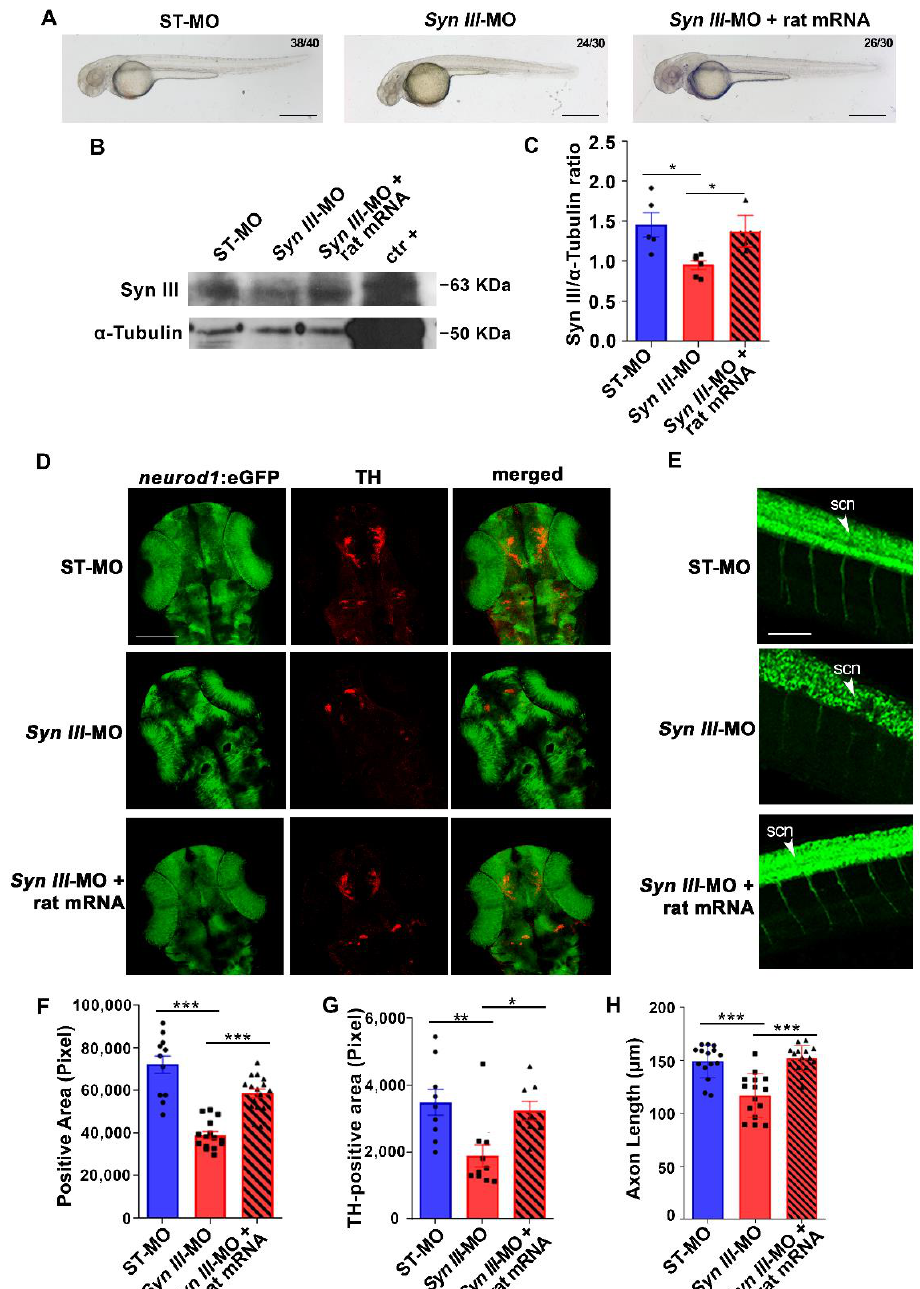
Figure 4. The neurodevelopmental deficits rescued by rat Syn III mRNA expression of Syn III -MO- injected Tg( neurod1 :eGFP) embryos involve TH-positive dopaminergic neurons. ( A ) Representative images showing embryos injected with non-silencing ST-MO, Syn III -MO or Syn III -MO and rat mRNA ( Syn III- MO + rat mRNA). Scale bars, 100 μm. ( B ) Representative WB from protein extracts of ST-MO-, Syn III -MO- or Syn III -MO + rat mRNA-injected Tg( neurod1 :eGFP) embryos. The positive control is a protein extract obtained from the striatum of twelve-month-old C57BL/6J wt mice. Al- pha-Tubulin bands are representative of the equal loading of samples. ( C ) Graphs show the ratio between the optical de nsity (o.d.) of Syn III and α -Tubulin of ST-MO, Syn III -MO, and Syn III -MO + rat mRNA-injected Tg( neurod1 :eGFP) embryos. Syn III was significantly reduced in the embryos exposed to syn3 KD when compared to either control or Syn III -MO + rat mRNA (* p < 0.05, One- way Anova + Newman-Keuls, n = 5 zebrafish protein pools per experimental condition). ( D ) Repre- sentative images showing TH immunostaining on 48 hpf Tg( neurod1 :eGFP) embryos injected with